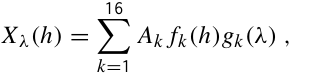
Fig. 6. Relative contribution of the different XUV/EUV lines to the total electron density versus latitude in km. Notice that the scales of the abscissa vary by more than one order of magnitude. Discretization effects show up at very low electron